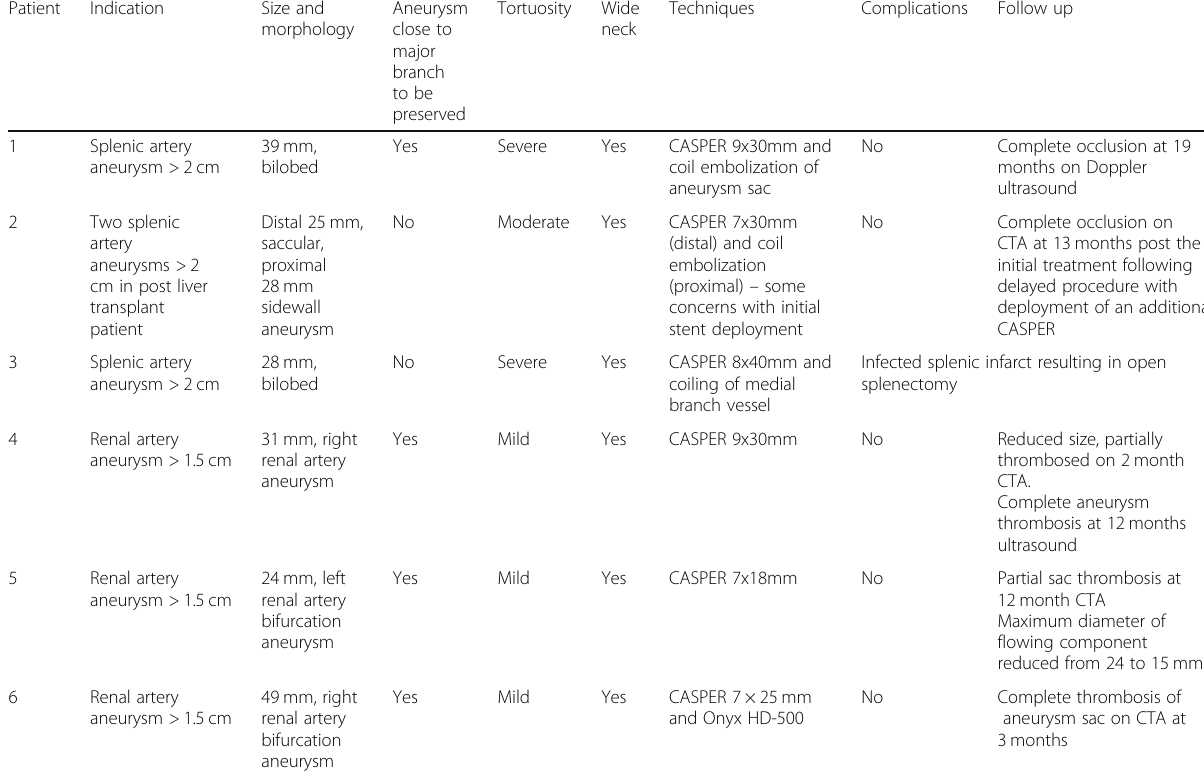
Table 1 Baseline imaging features and treatment